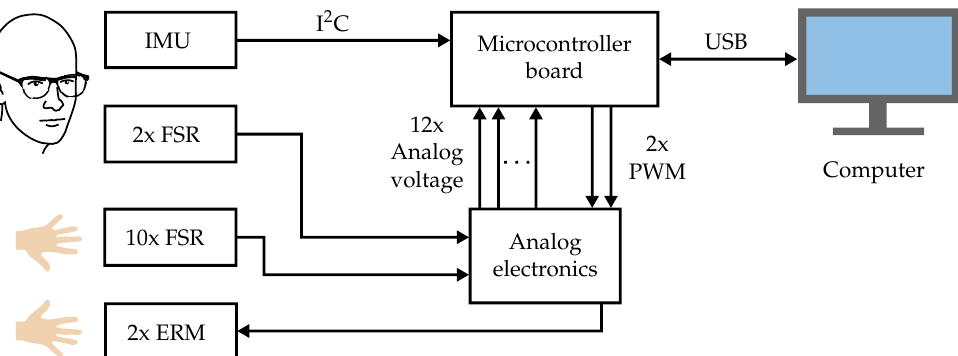
Figure 6. Block diagram of the human–computer interface. The hardware is connected to a computer via USB. A microcontroller board mediates communication between the user and the computer. The keyboard alternative consists of ten FSRs measuring finger contact pressures and two ERMs for vibrotactile feedback. One IMU measuring head orientation and two FSRs detecting masticatory muscle contraction attached to a spectacle frame constitute the mouse replacement. The measured head orientation is sent to the microcontroller via I 2 C. The resistance values of the FSRs are converted to analog voltages by voltage dividers and read by the microcontroller’s built-in ADC. All the sensory data are sent to the computer for further signal processing. The computer sends commands for vibrotactile feedback to the microcontroller which in turn controls the ERMs with PWM